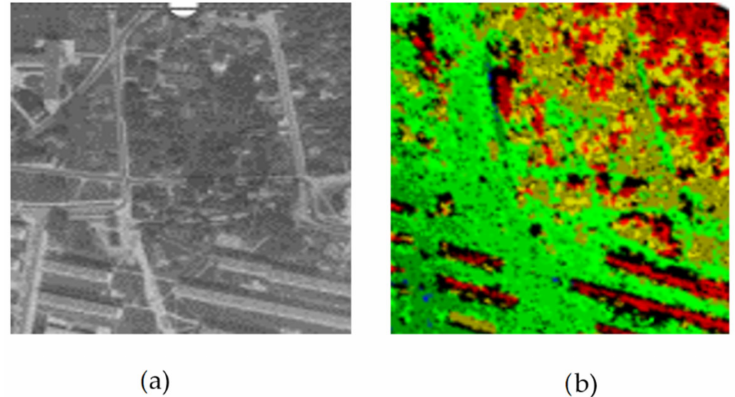
Figure 7. Problem of forested areas: ( a ) archive image, ( b ) dense point